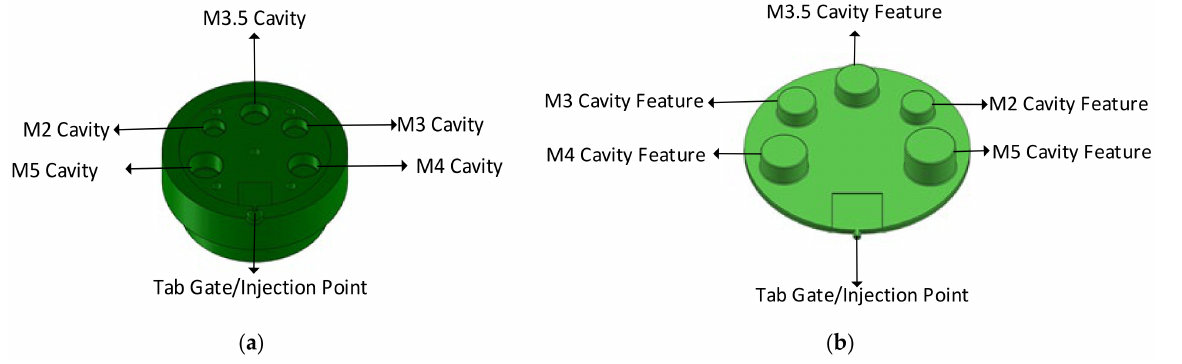
Figure 3. ( a ) Cavity side of 3DIM showing cored holes; ( b )f of the part formed by cavity